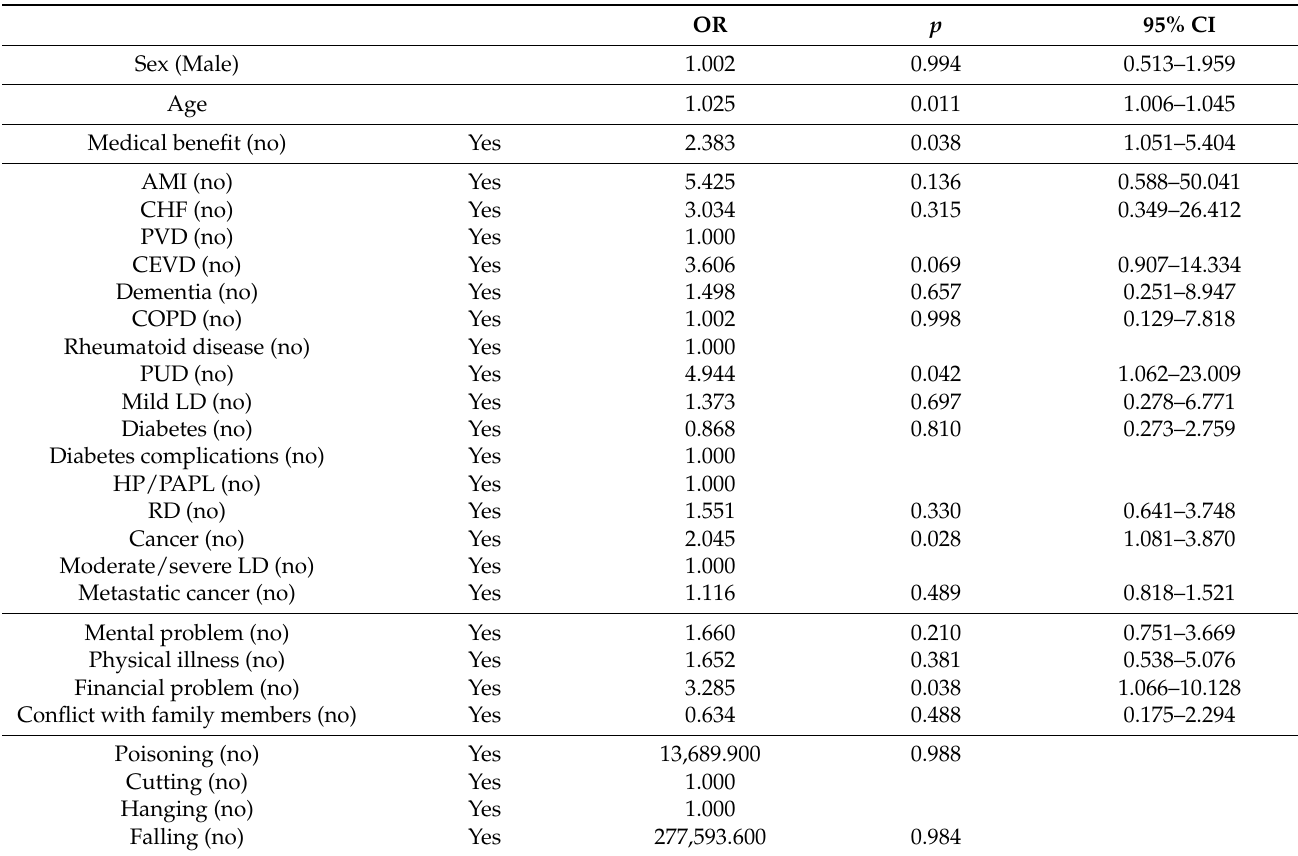
Table 2. Factors influencing self-harm in the hospital setting.